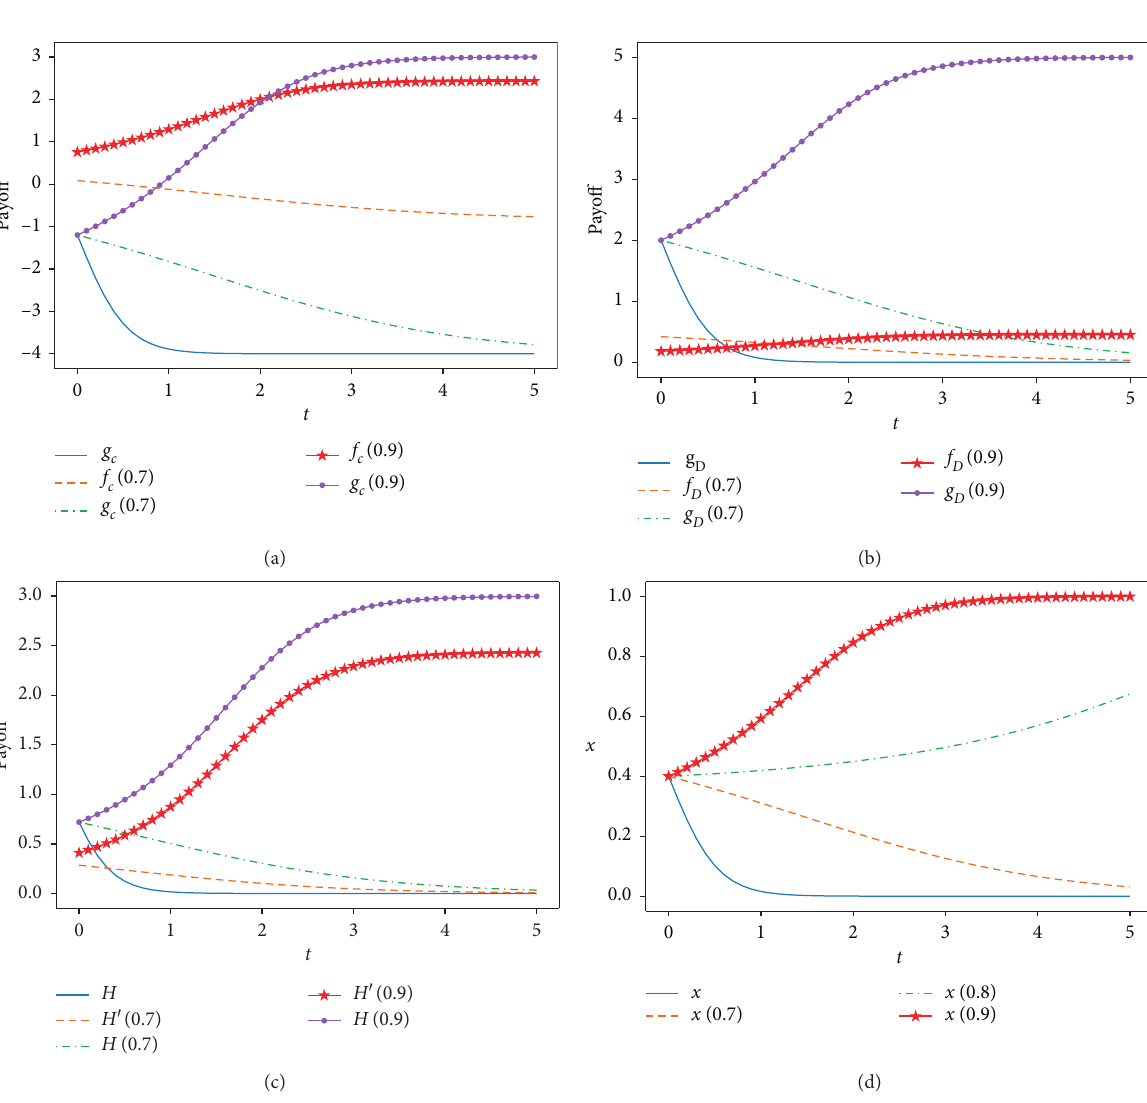
Figure 1: (a). The payoffs of the cooperator. (b). The payoffs of the defector. (c). The payoff of the group. (d). Evolution of the cooperation under